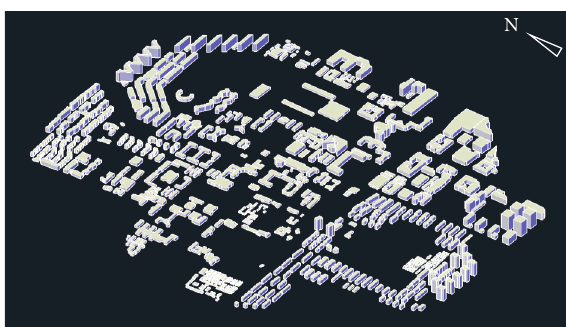
Figure 7: The original 3D model of the building group.